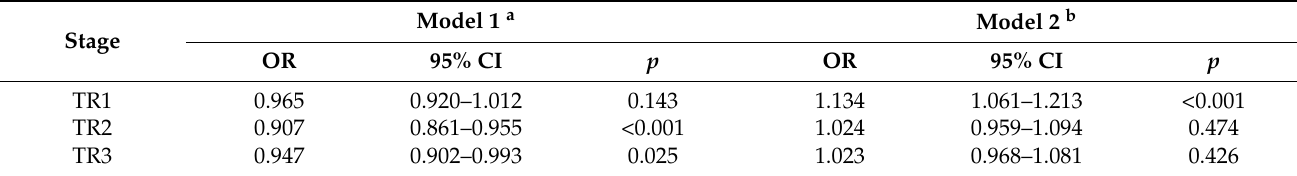
Table 3. Risk of preterm births by PM 2.5 (10 µg/m 3 ) exposure in three trimesters.